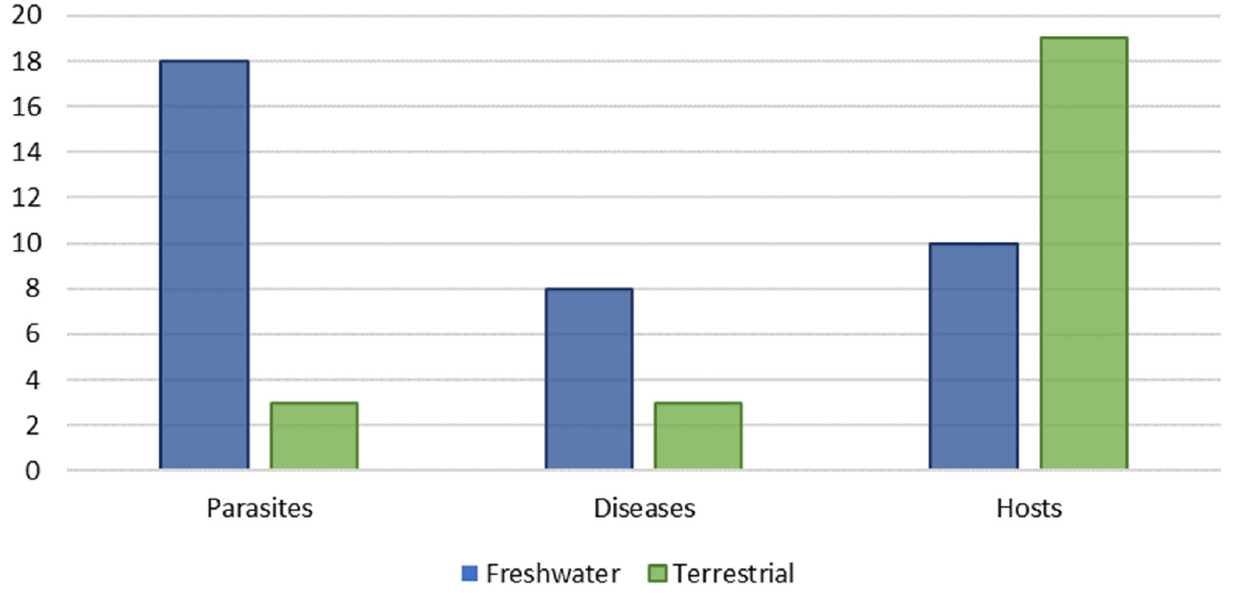
Figure 11. Diversity of parasites, transmitted diseases and hosts depending on the biology of the hosts, freshwater molluscs (blue) and terrestrial (green).